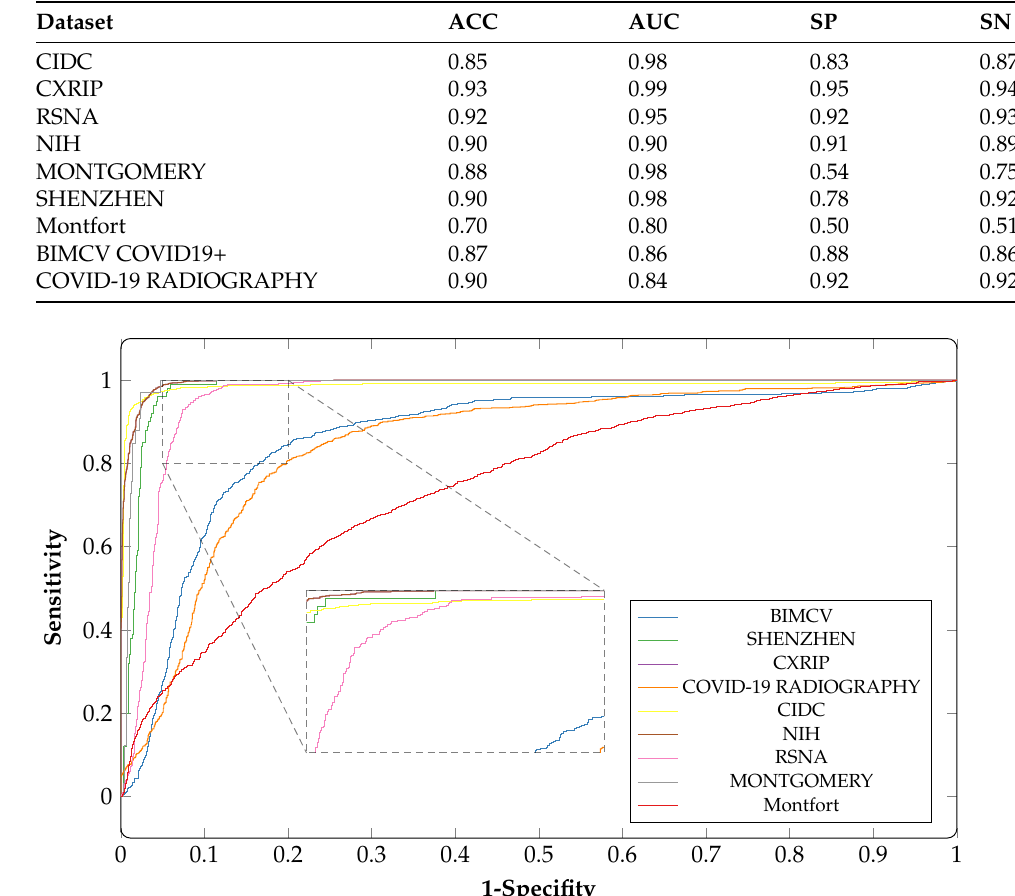
Figure 23. ROC curves of DeepCCXR-Multi for detecting COVID-19 in nine